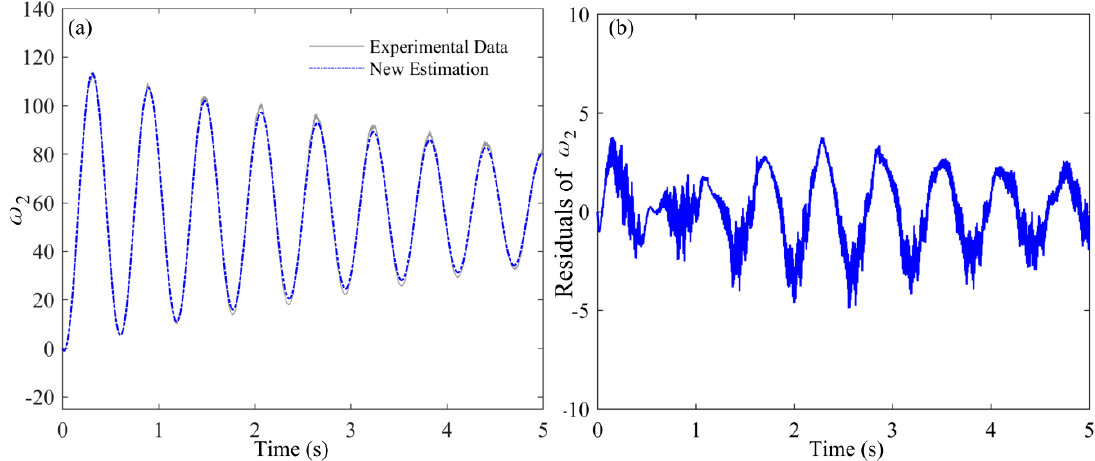
Figure 5. Tracking effect and identification error of the simulation model on the angular velocity of joint II: ( a ) tracking effect; ( b ) tracking error.